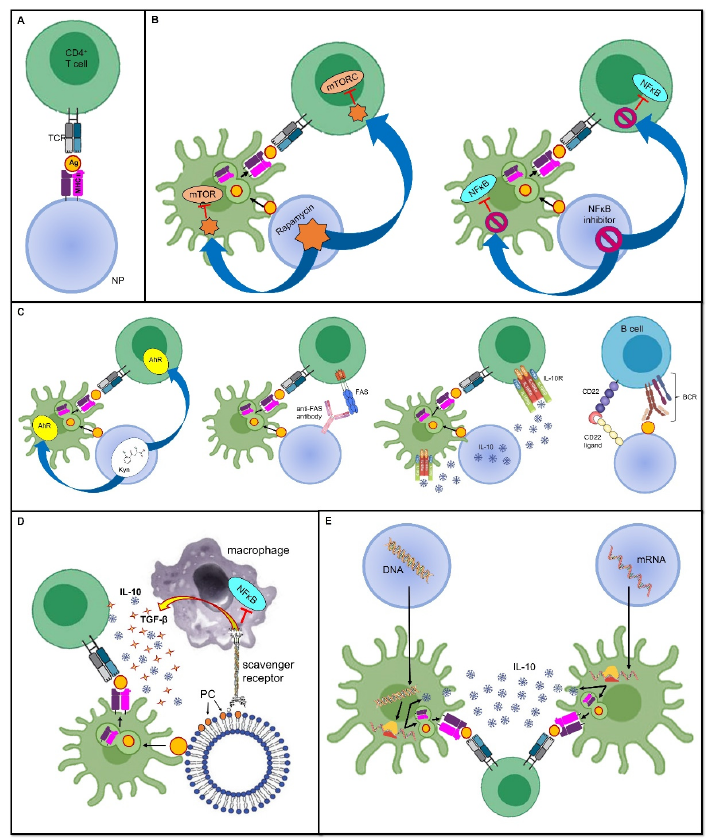
Figure 1. Tolerance-inducing strategies in tolerogenic vaccines. Mechanisms through which tolerogenic vaccines can induce an antigen-specific tolerogenic phenotype during the immune response. For the sake of simplicity, all vaccines are represented as being delivered through nanoparticles, even though several other delivery modes can be employed. Dimensions are not to scale. First, the antigen is usually endocytosed and processed by DCs; thereafter, the antigen is presented on MHC II and naive T cells. The tolerogenic adjuvant is delivered together with the antigen, and it has an effect on both the DCs and T cells interacting with them. ( A ) Deprivation of co-stimulatory signals. If the antigen is directly displayed on the MHC II molecule that is being carried by the vaccine, and in the absence of DC mediation and without co-stimulators, the T cell becomes anergic despite antigen recognition. ( B ) Inhibition of pro-inflammatory stimuli. Delivering the inhibitors of transcription factors that promote inflammation and cell proliferation is an additional strategy that can dampen the T cell response. ( C ) Induction of a tolerogenic phenotype. Engagement between signaling pathways are able to downregulate T or B cell activation, or it can induce programmed cell death. ( D ) Mimicry of tolerogenic physiological mechanisms. These strategies harness the physiological “neat death” (apoptosis) of cells; for instance, by displaying the apoptotic marker, PS, thus preventing an inappropriate inflammatory reaction. ( E ) Nucleic acid-based vaccines. The nanoparticle-delivered DNA coding for the specific antigen, as well as for a tolerogenic molecule, is first incorporated in the DC nucleus, then transcribed into an mRNA molecule, and eventually translated into a protein antigen plus the tolerogenic molecule. The former is loaded on an MHC II and presented to naive T cells, whereas the latter acts both on the DC itself and on naive T cells to induce a tolerogenic phenotype. In mRNA-based vaccines, the mechanism is very similar, with the only difference being that the transcription step is skipped, and therefore, the mRNA molecule is directly translated due to the DC ribosomes. Abbreviations . Ag, antigen; BCR, B cell receptor; CD22, cluster of differentiation 22; IL-10, interleukin-10; mTORC, mammalian target of rapamycin complex; NF κ B, nuclear factor- κ B; NP, nanoparticle; PC, phosphatidylcholine; TCR, T cell receptor; TGF- β , transforming growth factor- β